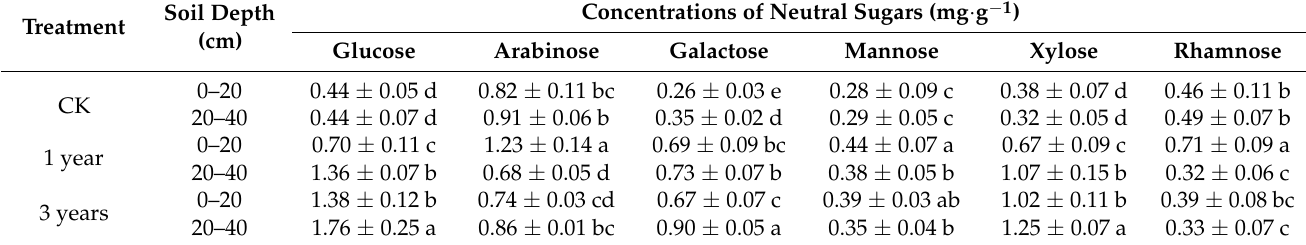
Table 3. Effects of returning shoots on the concentrations of neutral sugars (mean ± SD). Different lowercase letters in the same figure indicate significant differences at the 0.05